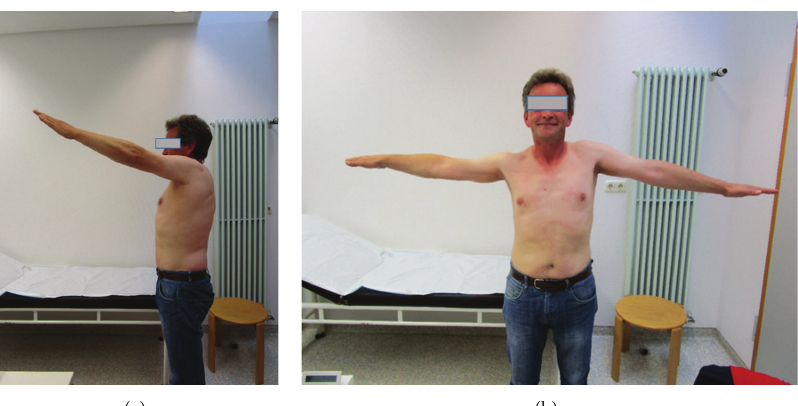
Figure 7: (a), (b) At follow-up 6 months after the index procedure the patient shows a good functional outcome and is very satisfied with the